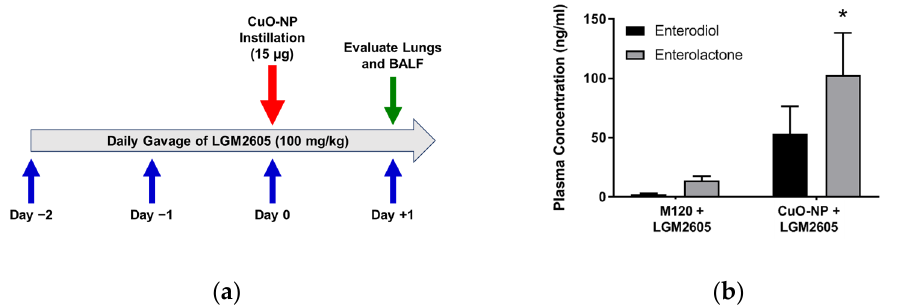
Figure 3. Experimental Scheme and Plasma Levels of LGM2605 (Synthetic SDG) Metabolites in Mice. ( a ) displays the experimental scheme, where LGM2605 administration was initiated 2 days prior to CuO-NP exposure; ( b ) shows the plasma levels of LGM2605 (synthetic SDG) metabolites, the mammalian lignans enterodiol (ED) and enterolactone (EL), in mice exposed to M120 or CuO-NP ( n = 5 per group) using LC-MS/MS. Data are presented as the mean ± the standard error of the mean. Asterisks indicate a statistically significant difference (* p < 0.05) from M120 + LGM2605. Bronchoalveolar lavage (BAL) was performed and fluid evaluated from lungs treated with M120 control or CuO-NP to determine the immune response and extent of lung injury.